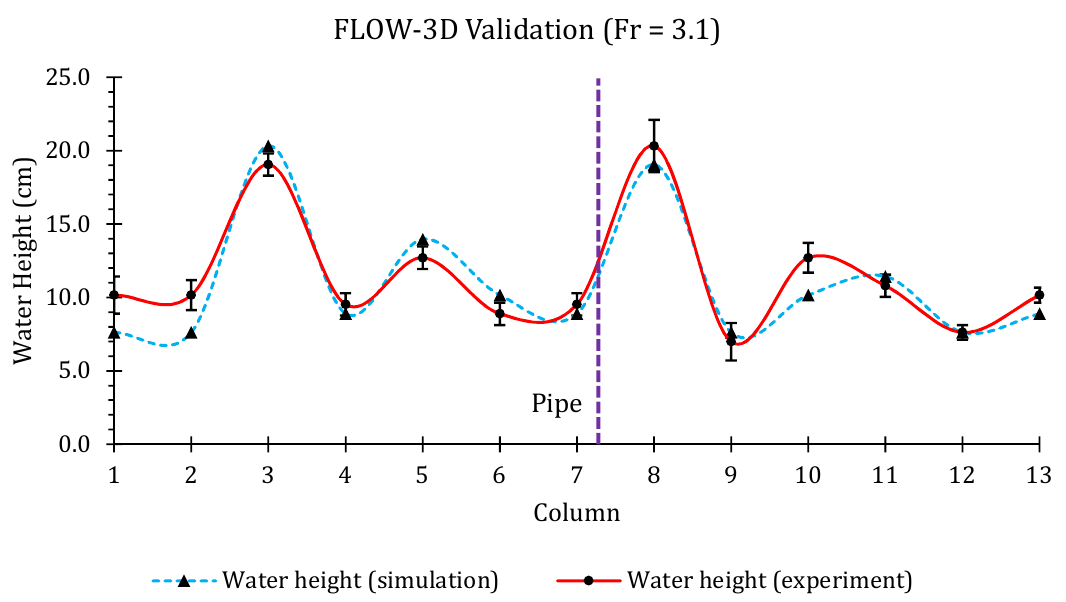
Figure 25. Water heights in the flume and based on FLOW-3D results, for Fr = 3.1. Table 10. FLOW-3D validation results.